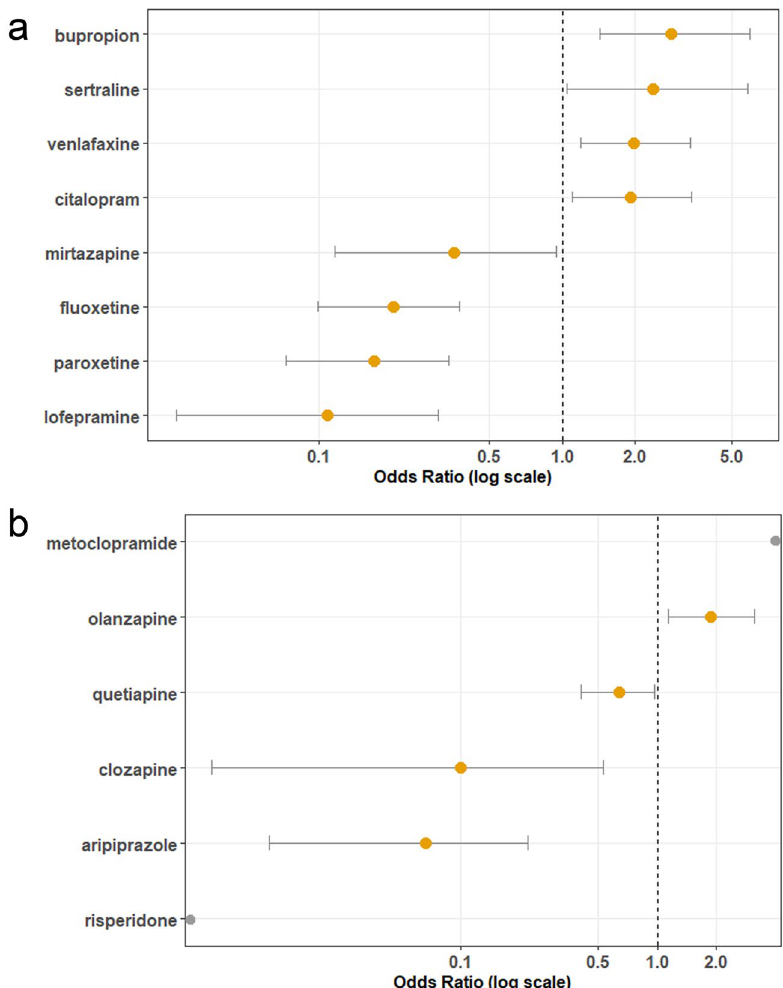
Figure 4. Univariate analysis of impact of common antidepressants and antipsychotics on odds of death in MDMA records. Univariate unadjusted odds ratios for the reported risk of death shown for records with concomitant use of each drug. X-axis presented here in log scale. Significant findings shown here in orange and non-significant findings are denoted in grey. 95% Confidence intervals shown as whiskers. Odds Ratios greater than 1 indicate an increased reported risk of death. ( a ) Odds of death shown for antidepressants with greater than 10 records in the dataset. ( b ) Odds of death shown for antipsychotics with greater than 10 records in the dataset (note that the odds ratio for metoclopramide is incalculable due to no occurrences of survival in the study, conversely the odds ratio for risperidone is incalculable due to no occurrences of death during the